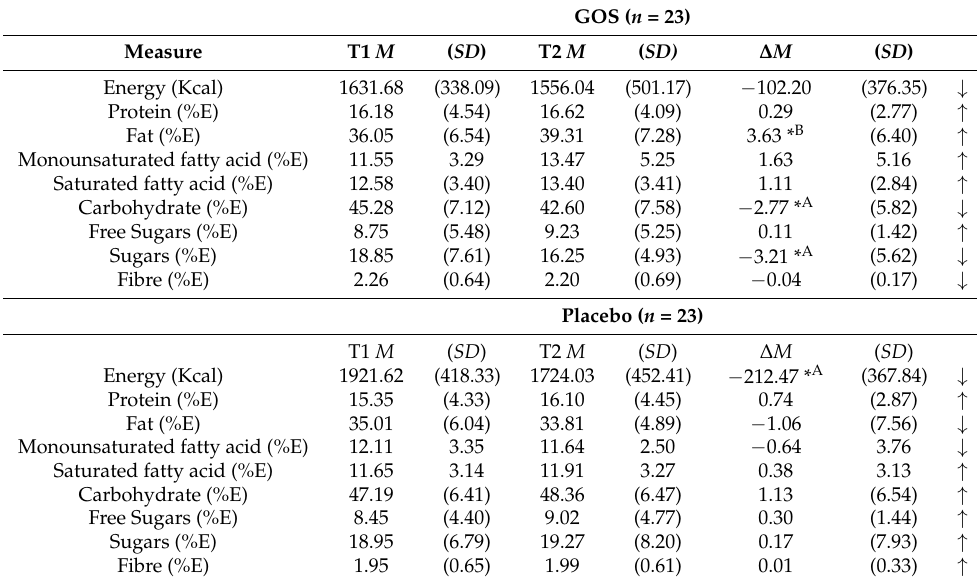
Table 1. Descriptive measures of nutrient intake pre- and post-intervention for young women, by treatment